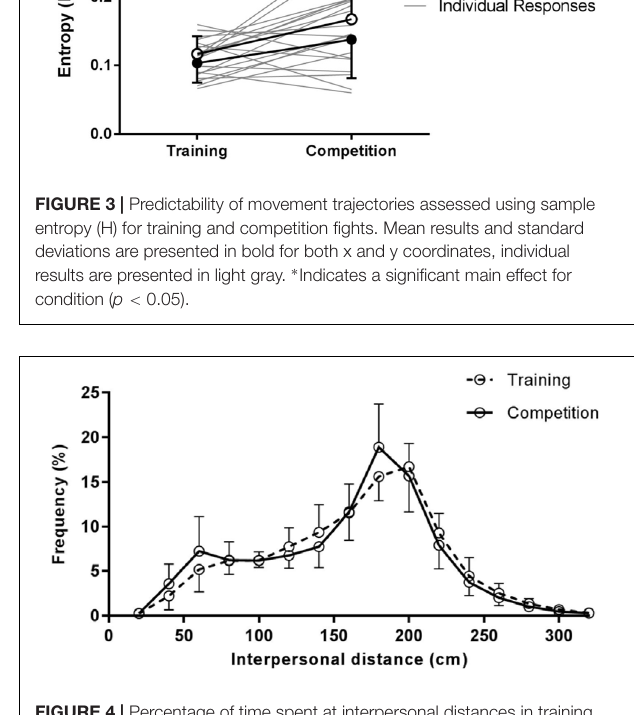
FIGURE 4 | Percentage of time spent at interpersonal distances in training and competition fights. Interpersonal distances are presented in 0.20 m bins.